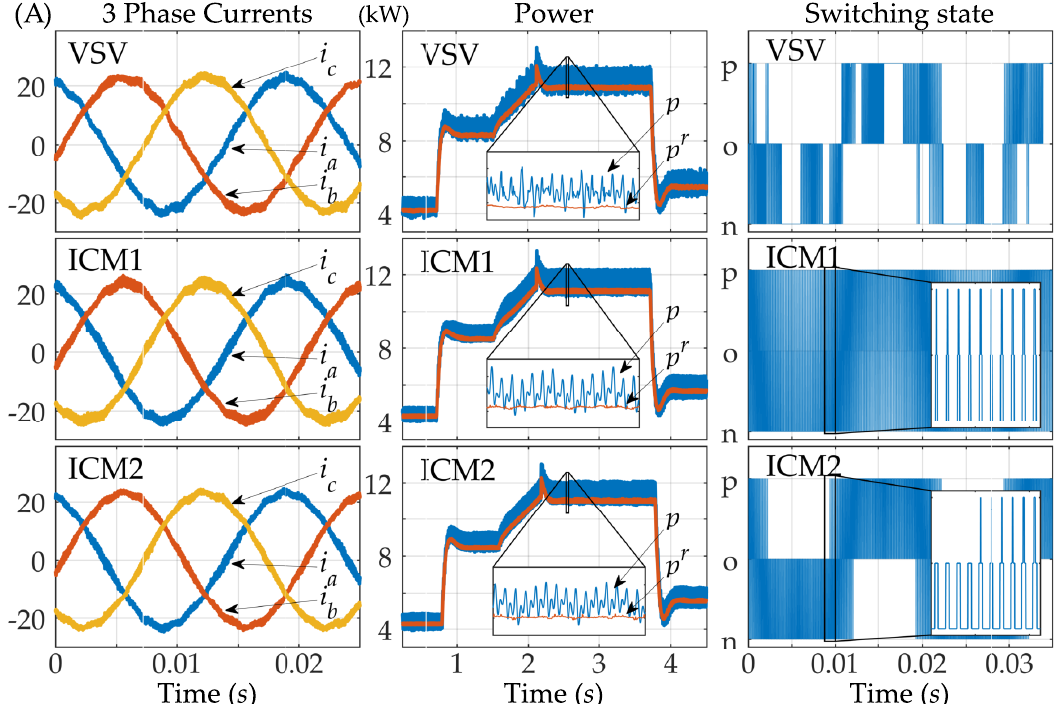
Figure 6. Experimental results: ( Left ) Phase currents at steady state with v dc = 800 V , R = 60 Ω for the mVSVPWM (denoted as VSV in the figure legend), ICM1 and ICM2; ( Center ) evolution of the instantaneous power ( p ) and its reference ( p r ) along different operating conditions for the three modulation approaches considered; ( Right ) switching states at steady state with v dc = 800 V , R = 60 Ω for the three